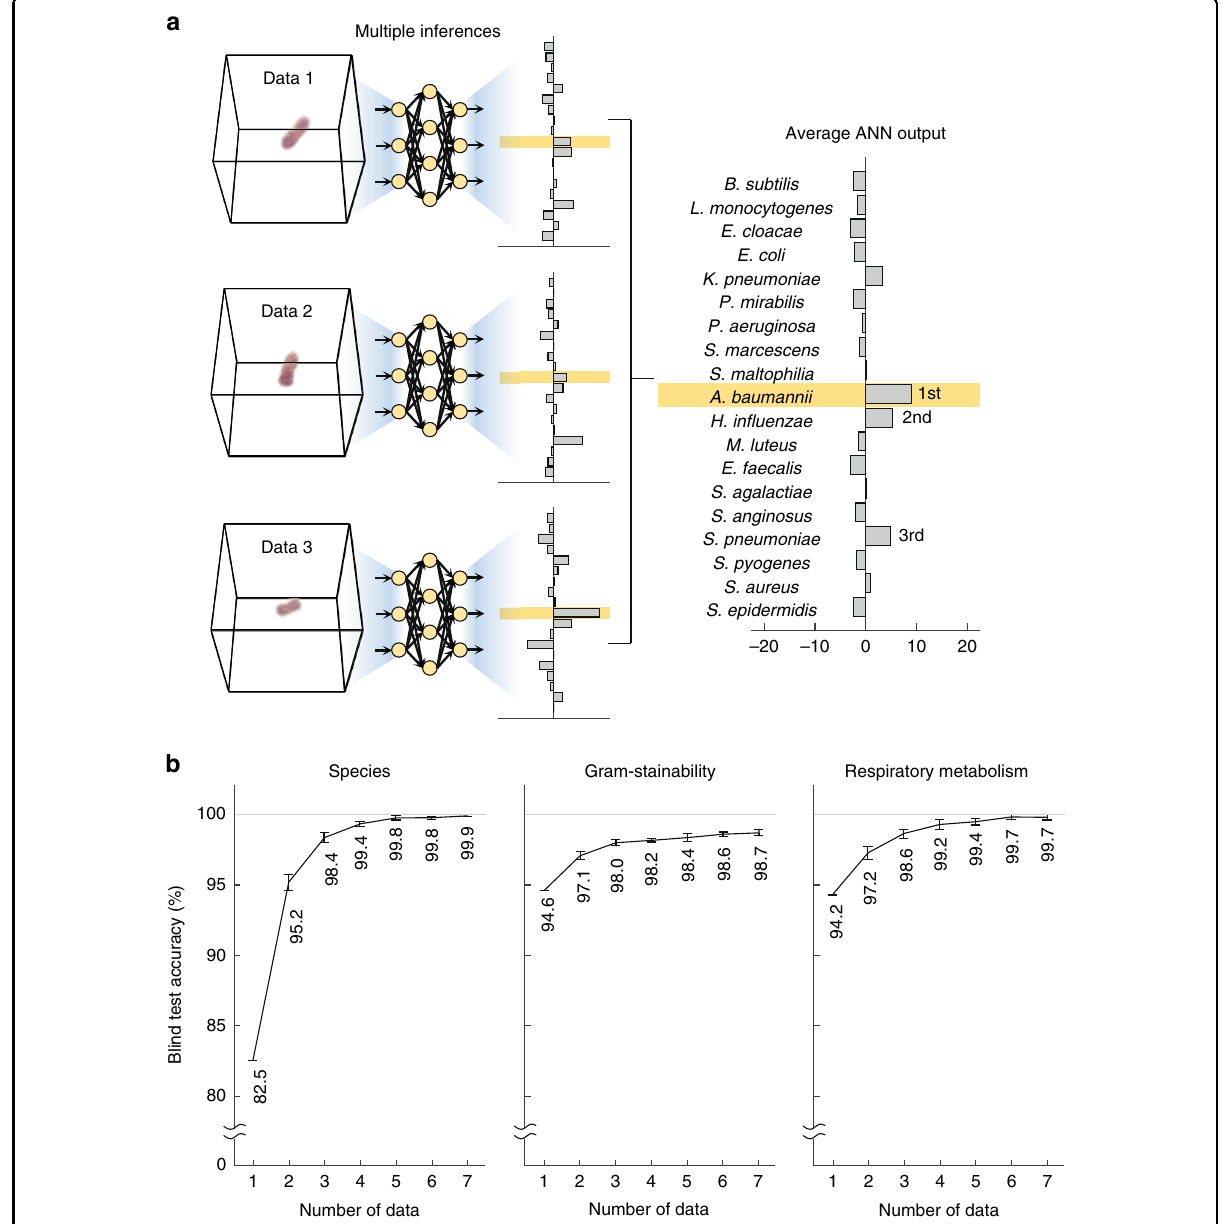
Fig. 6 Species identi fi cation based on multiple measurements of 3D RI tomograms. a Securing a higher accuracy by taking the average of ANN outputs resulting from multiple tomograms. The highlighted species indicate the correct species in each ANN output. b Reduction of error in classifying the species, gram-stainability, and respiratory metabolism. The error reduction is sharper than a simple reciprocal function owing to the feature-extracting ability of the arti fi cial neural